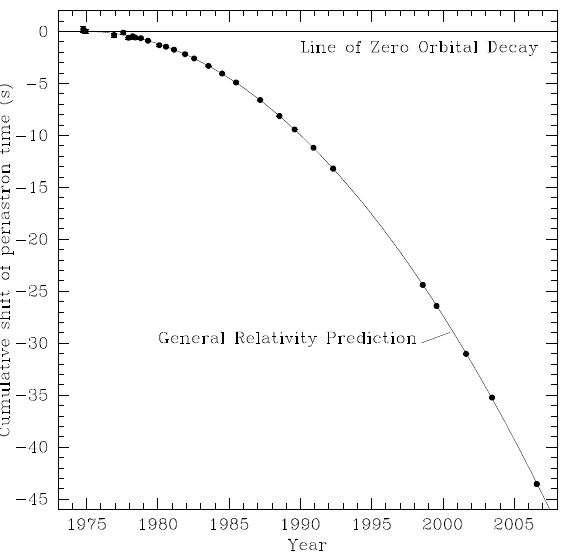
Figure 5. Binary Pulsar Advance of the Periastron (point of closest approach of the stars) versus Time. General Relativity predicts this change because of the energy radiated away by gravitational waves. Hulse and Taylor were awarded the Nobel Prize for this observation in 1993. Figure taken from (Living Rev.Rel.11:8, 2008).